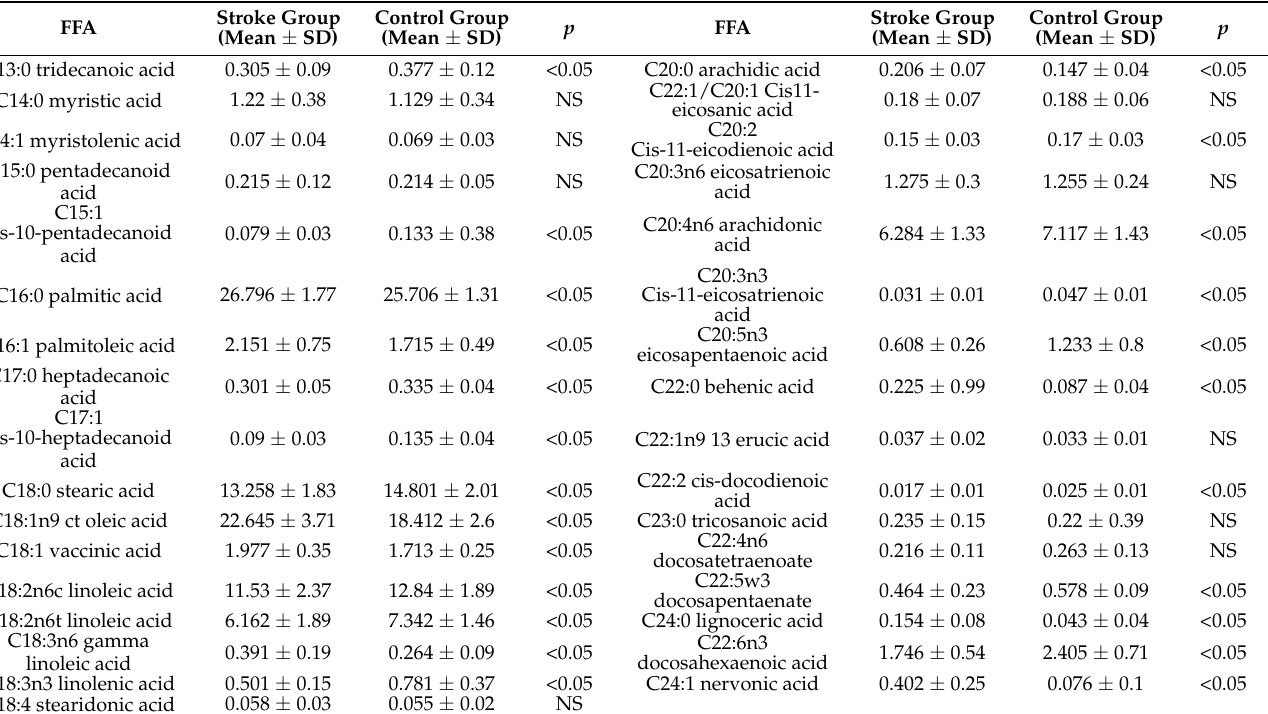
Table 7. Comparison between FFAs of stroke patients ( n = 72) and control group ( n = 30).